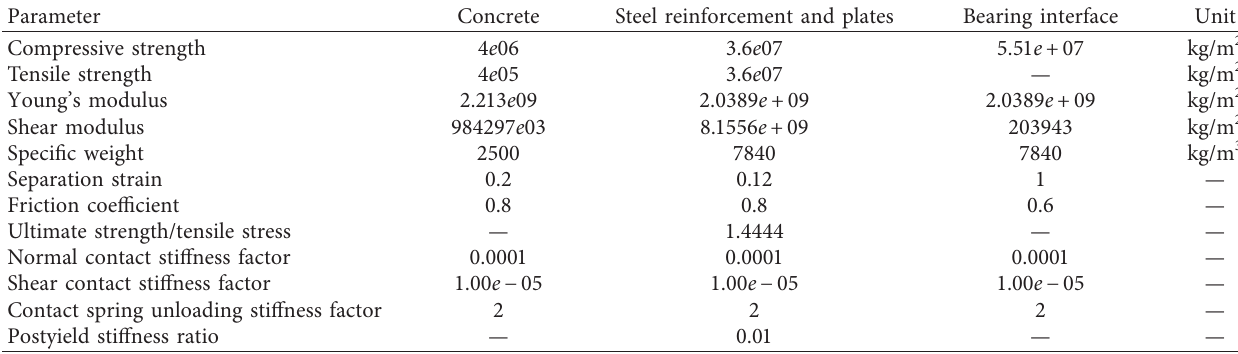
Table 3: Properties of the bridge